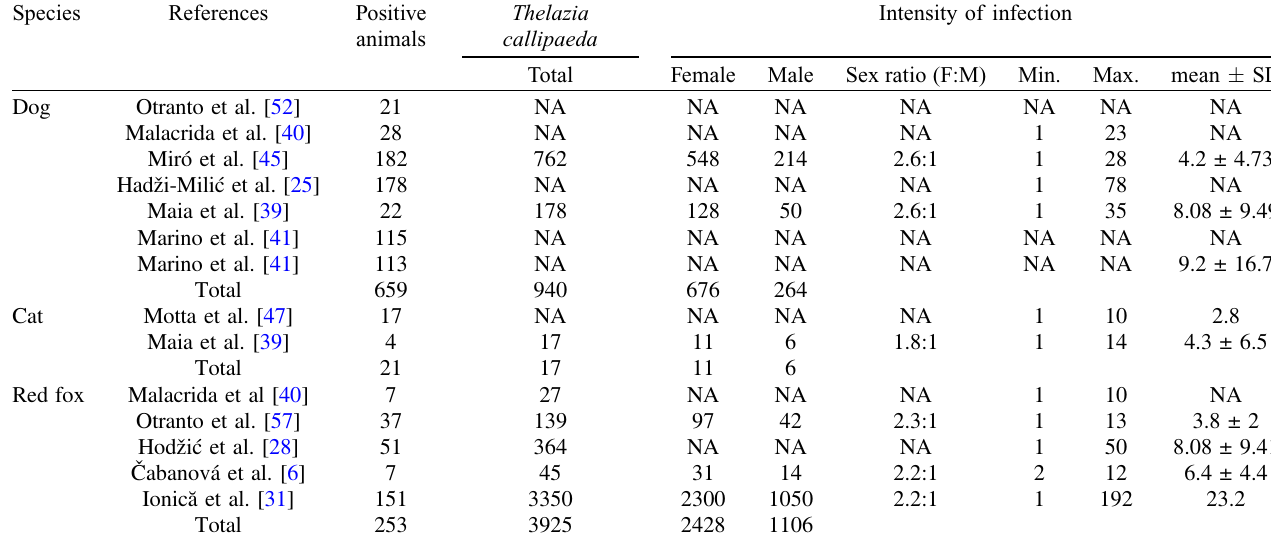
Table 5. Gender identi fi cation and intensity of T. callipaeda infection in the eyes of dogs, cats and red foxes from the cross-sectional studies.